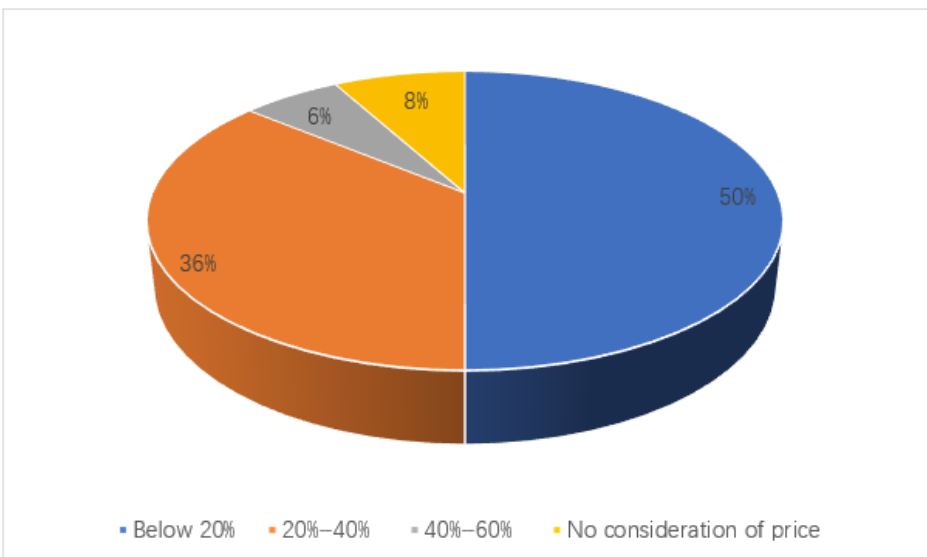
Figure 16. Premium acceptable to consumers.